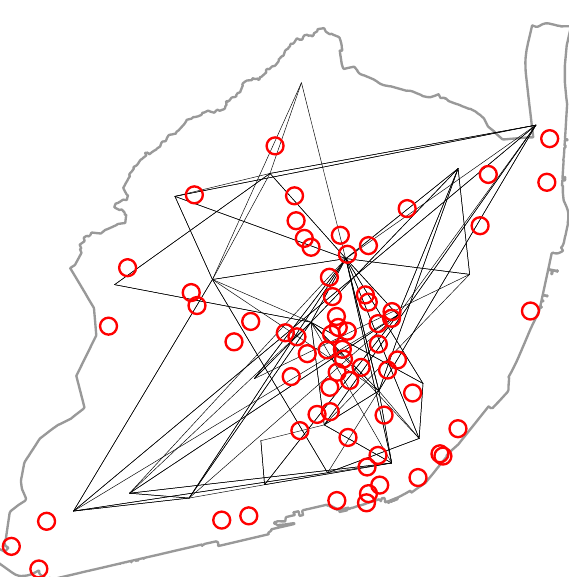
Figure 2. Trips represented with desire lines from centroids of 24 areas. The red circles represent the counters locations.